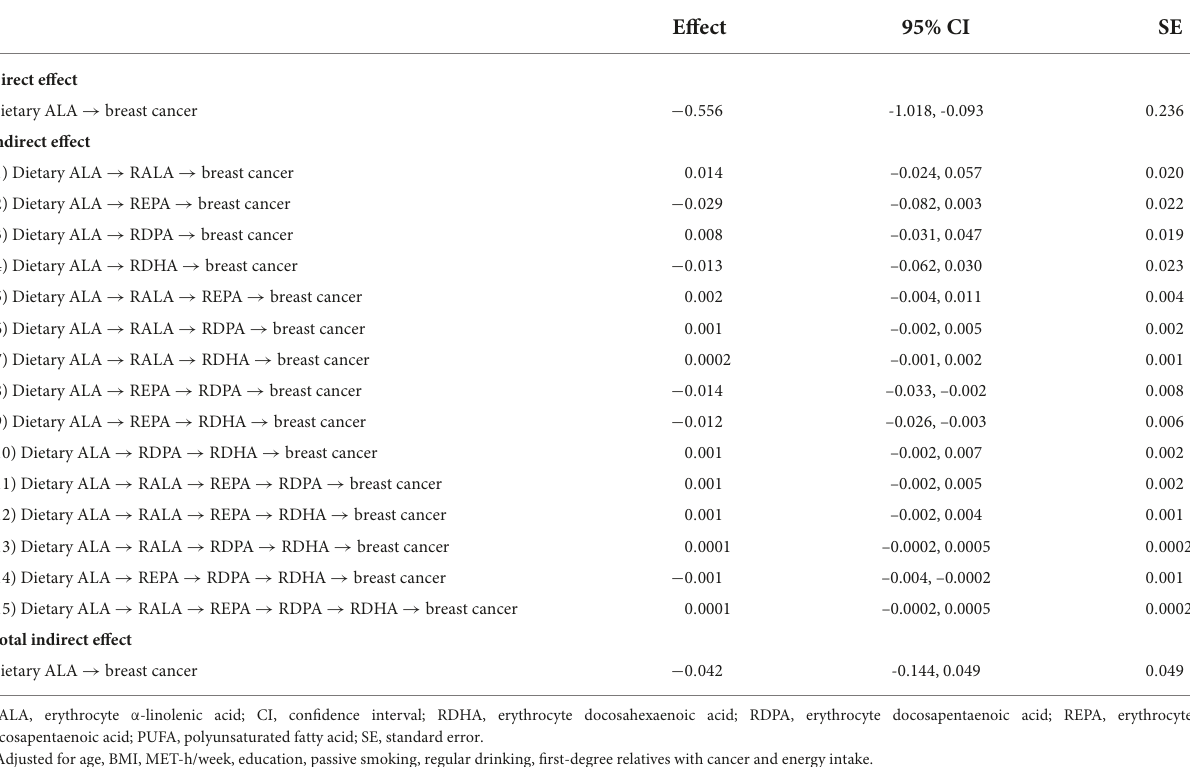
TABLE 4 Direct and indirect effect of the chain mediation model with mediator of erythrocyte n – 3 PUFAs in association between dietary ALA intake and breast cancer risk a .